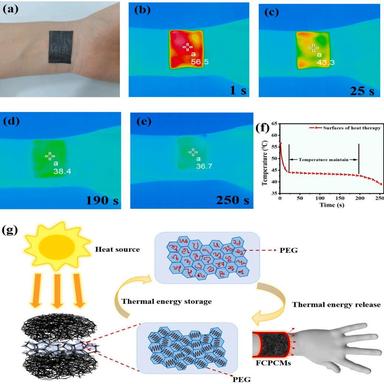
(a) Physical diagram of C400BC64-MF@PEG when placed on the wrist. (b-e) Infrared thermograms of temperature change over time. (f) Corresponding temperature retention curve. (g) Mechanism of thermal therapy effect.